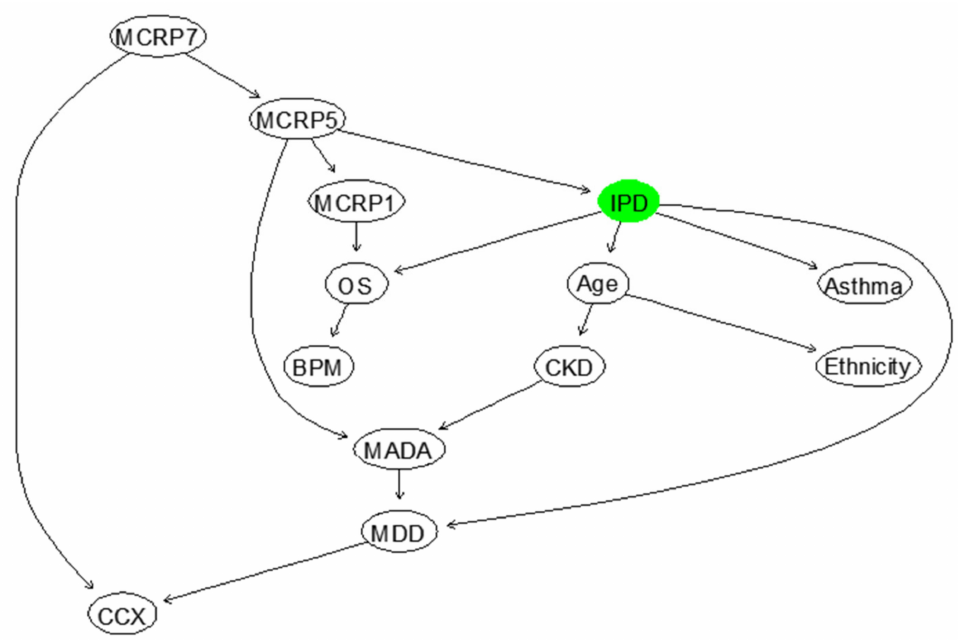
Figure 5. The BN that is fully learned from data to model “IPD” in terms of other relevant